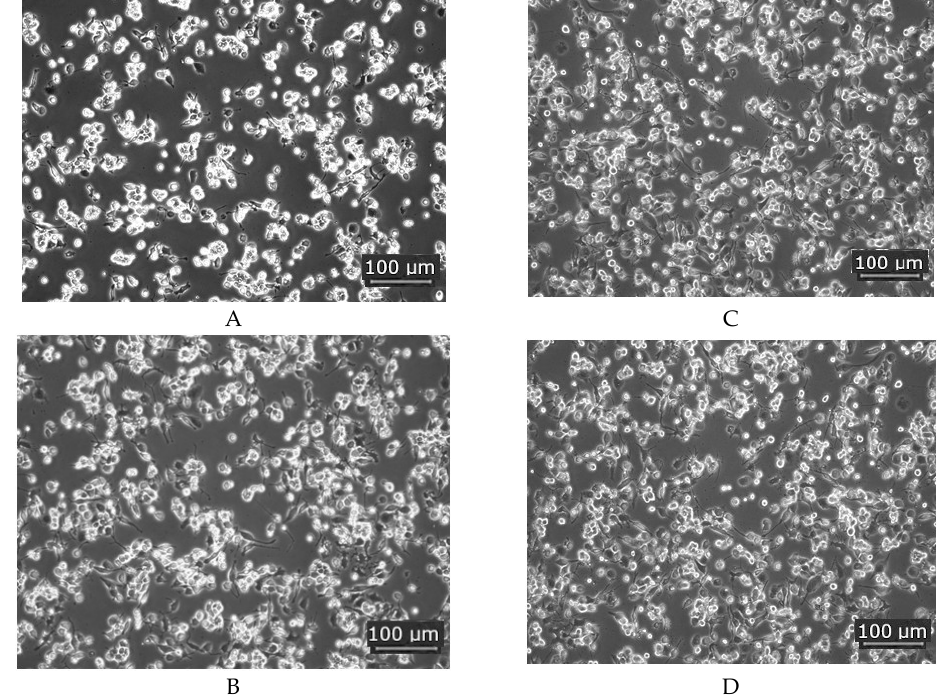
Figure 4. Imaging of macrophages culture. Cells were cultured in RPMI medium with 10% FBS – control condition for 24 h ( A ) and for control condition for 48 h ( B ); THP1-monocytes cultured in RPMI medium with 10% Fetal Bovine Serum (FBS) with Biodentine TM for 24 h ( C ) and for 48 h ( D ). Normal cells are visible. Experiments were conducted as six separate assays (each assay in three replicates).